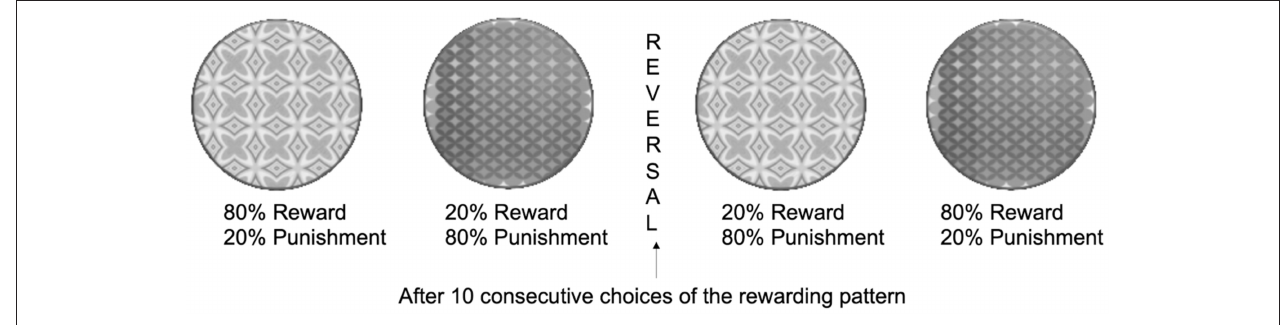
FIGURE 6 | Schematic representation of the probabilistic reversal learning test with examples of presented